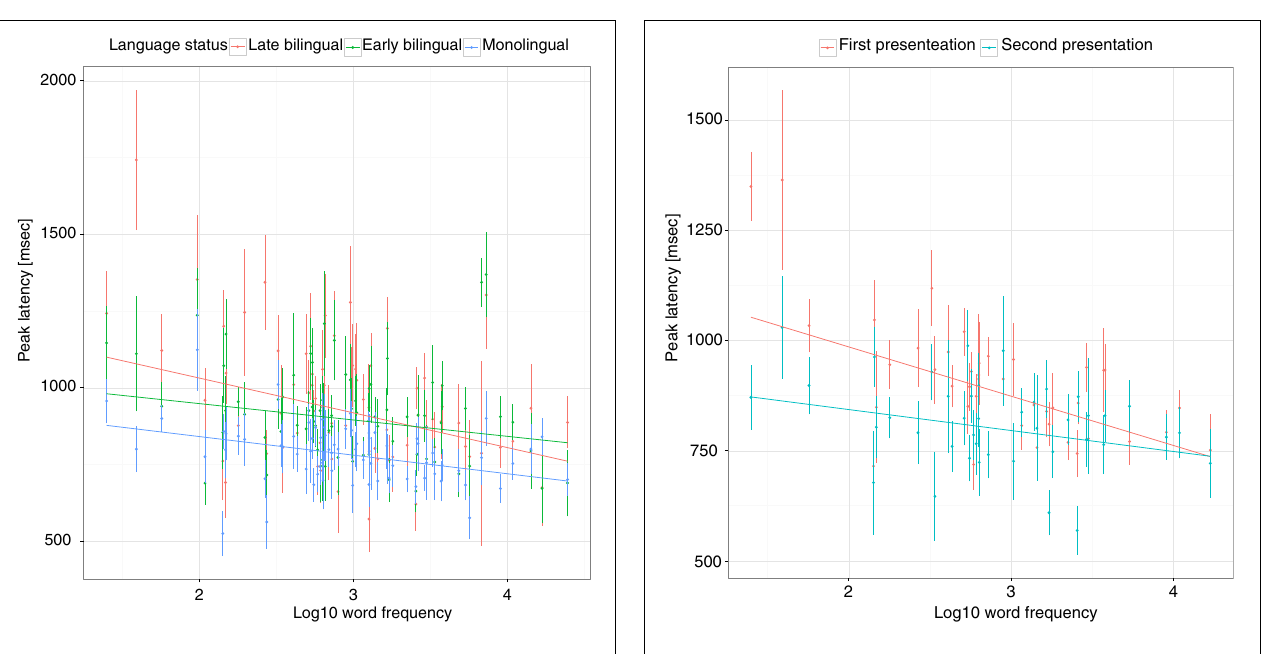
FIGURE 5 | The frequency effect as a function of target repetition. The effect is shown for repeated words only. Vertical lines and dots show the mean and standard error of individual items. Regression lines show the best